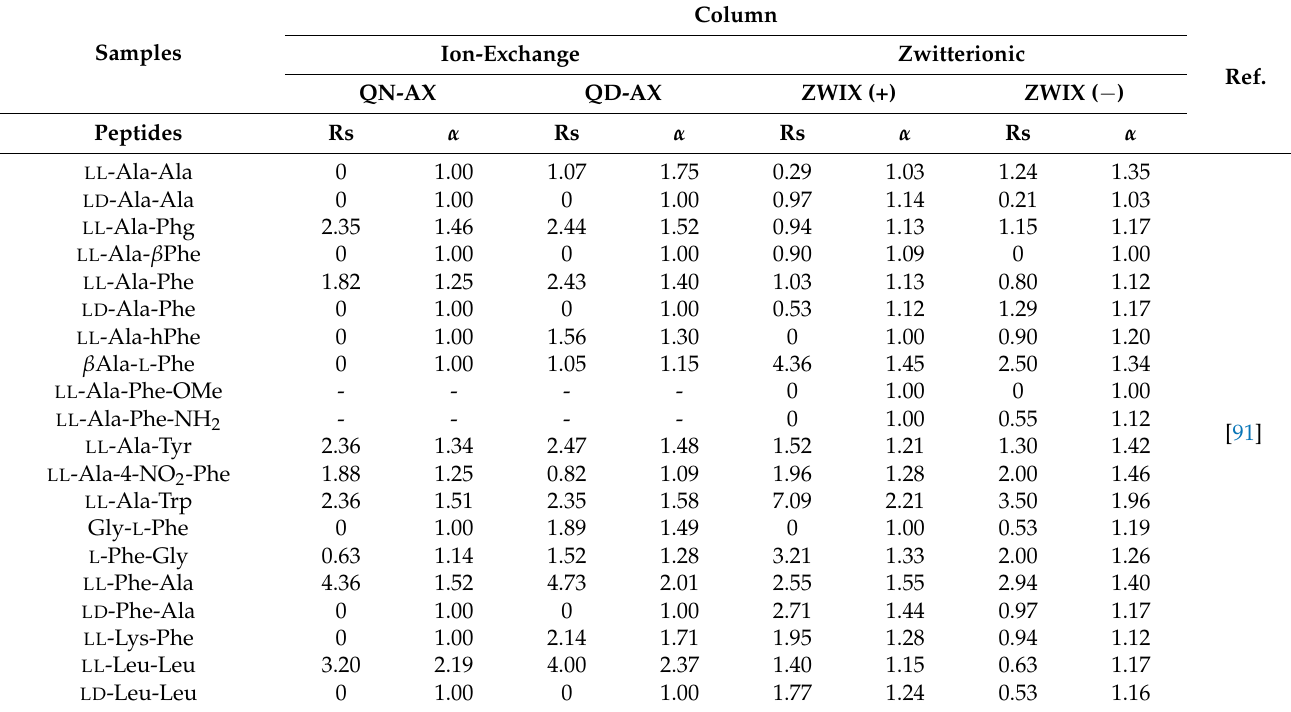
Table 5. Comparison of peptides separation performances using the ion-exchange (QN-AX and QD-AX) and zwitterionic (ZWIX (+) and ZWIX ( − ))